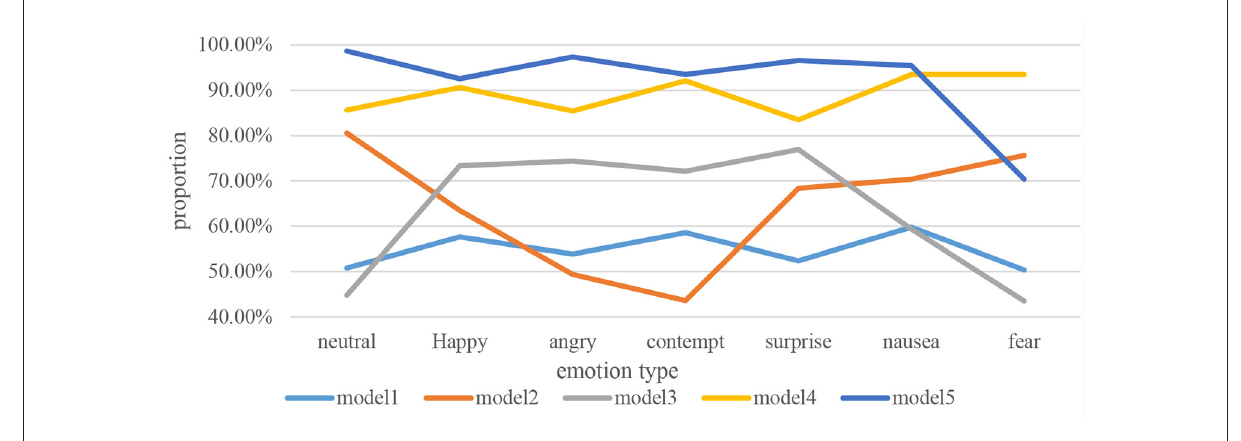
FIGURE9 Recognition rates of different emotions for different teaching